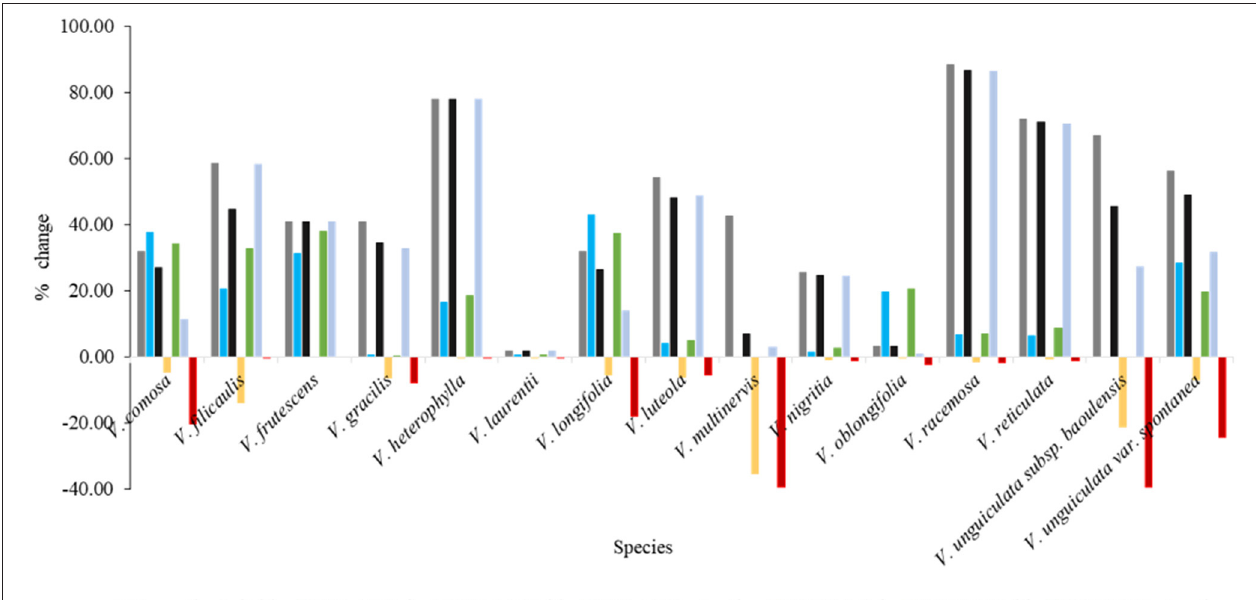
FIGURE 4 | Graph of per cent changes in the suitable habitat distribution ranges of the 15 Vigna CWR taxa in Benin under current and future climates.